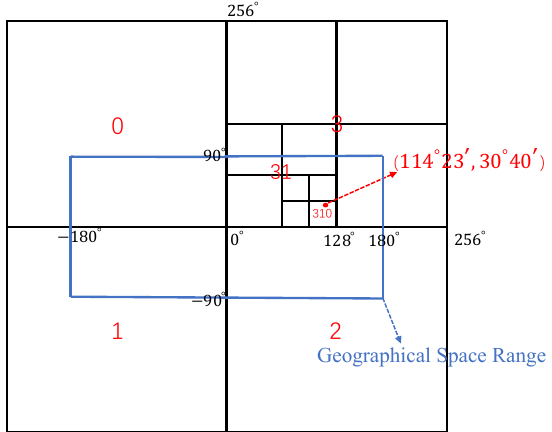
Figure 2. The diagram of spatial subdivision and coding of